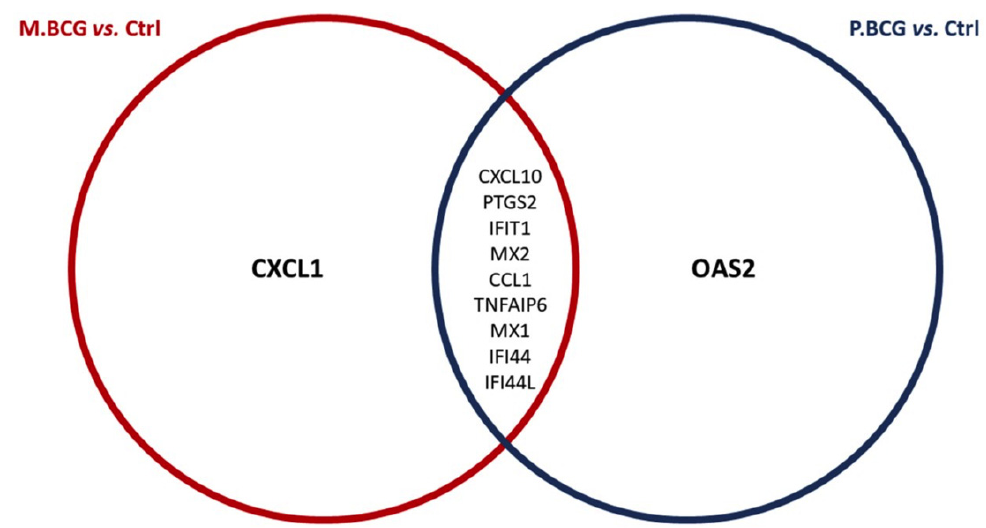
Figure 5. Venn diagram representing the differentiated genes within sets corresponding to the two IPA predictions. The intersections correspond to genes appearing in more than one prediction. Red circle: M.BCG vs. Ctrl; Blue circle: P.BCG vs Ctrl; M.BCG: Mycobacterium bovis Mexico; P.BCG: Mycobacterium bovis Phipps strain; Ctrl: control.